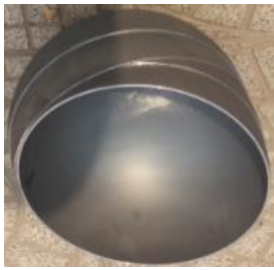
Figure 5. The cased hemispheres.